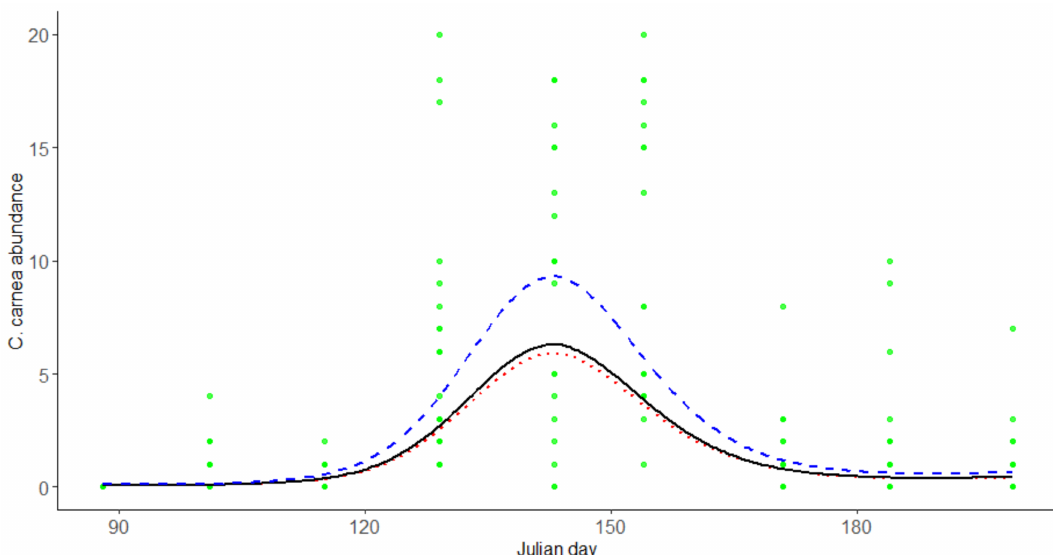
Figure 4. Abundance of C. carnea along time (in Julian days) under the influence of different P. oleae abundance levels. Black solid line represents the estimated abundance of C. carnea under the influence of P. oleae abundance of a quantile 50% of the observed data (2.0 individuals per trap per fifteen days). Red dotted line represents the estimated abundance of C. carnea under the influence of P. oleae abundance of a quantile 10% of the observed data (0.1 individuals per trap per fifteen days). Blue dashed line represents the estimated abundance of C. carnea under the influence of P. oleae abundance of a quantile 90% of the observed data (14.6 individuals per trap per fifteen